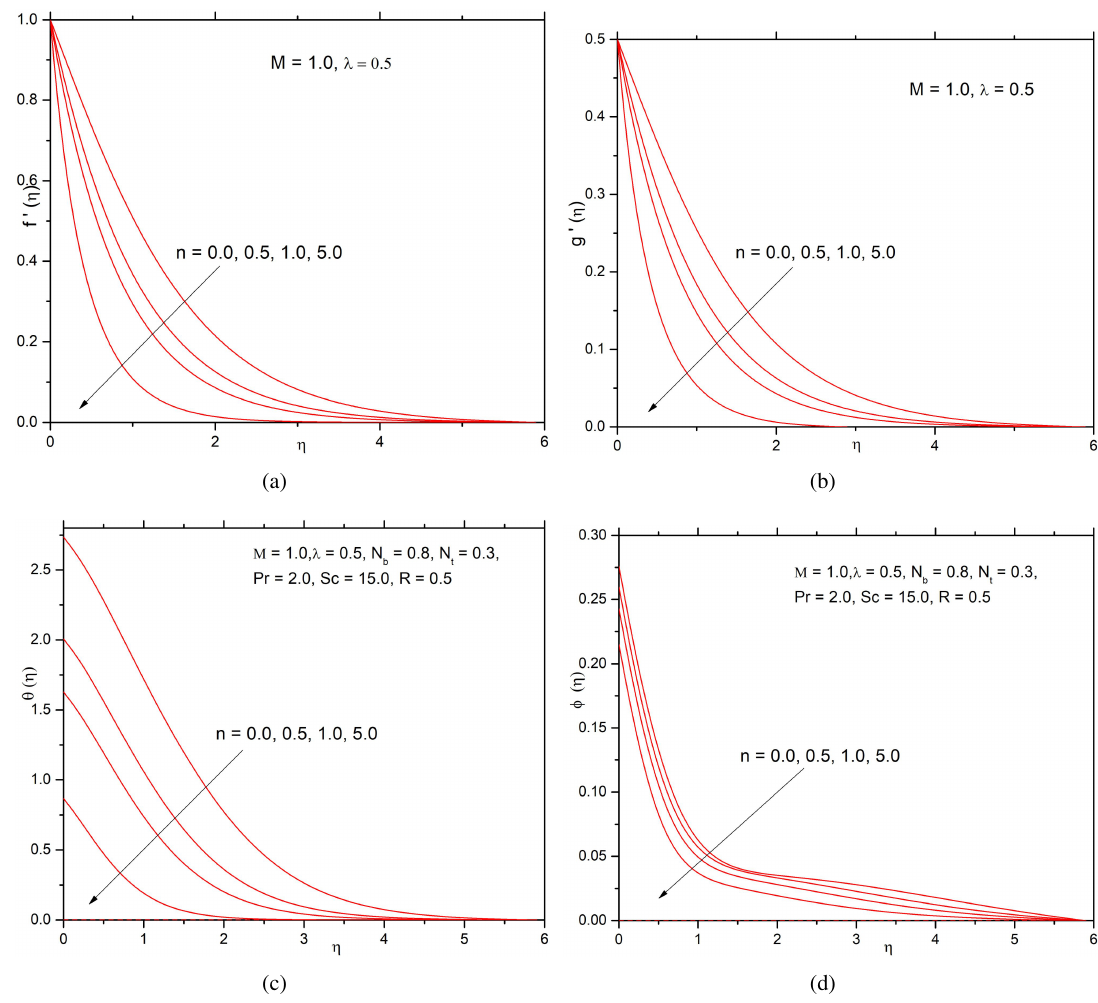
Fig. 4 Influences of n, non-linearly stretching parameter on (a) f (cid:48) ( η ) , velocity in the direction of x (b) g (cid:48) ( η ) , velocity in the direction of y , (c) θ ( η ) , temperature for PHF and (d) nanoparticle volume fraction ϕ ( η ) for